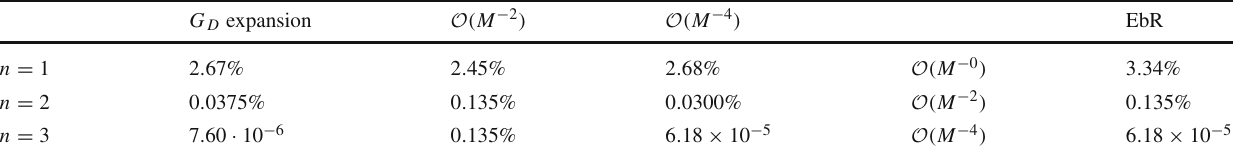
Table 2 The relative errors with respect to the full result of the dual the result obtained through Expansion by Regions. Numerical evalua- expansionasgivenfromEq.(28)(boththedirectresultofthisexpansion tion with parameters M = 10 m , p 2 = 3 m 2 , and μ UV = M and considering only the leading behaviour at large M ) compared with G D